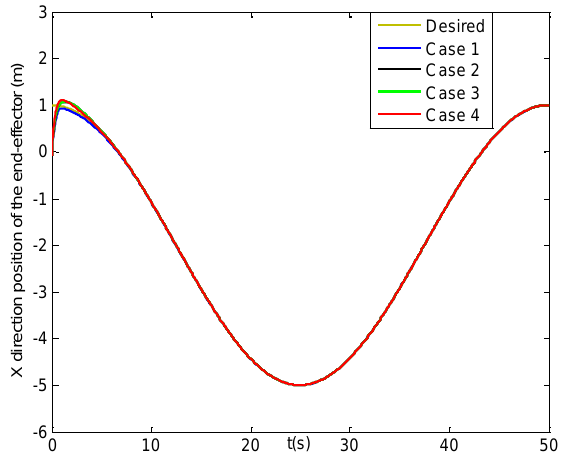
Figure 6. X direction positions of the end − effector (four cases).